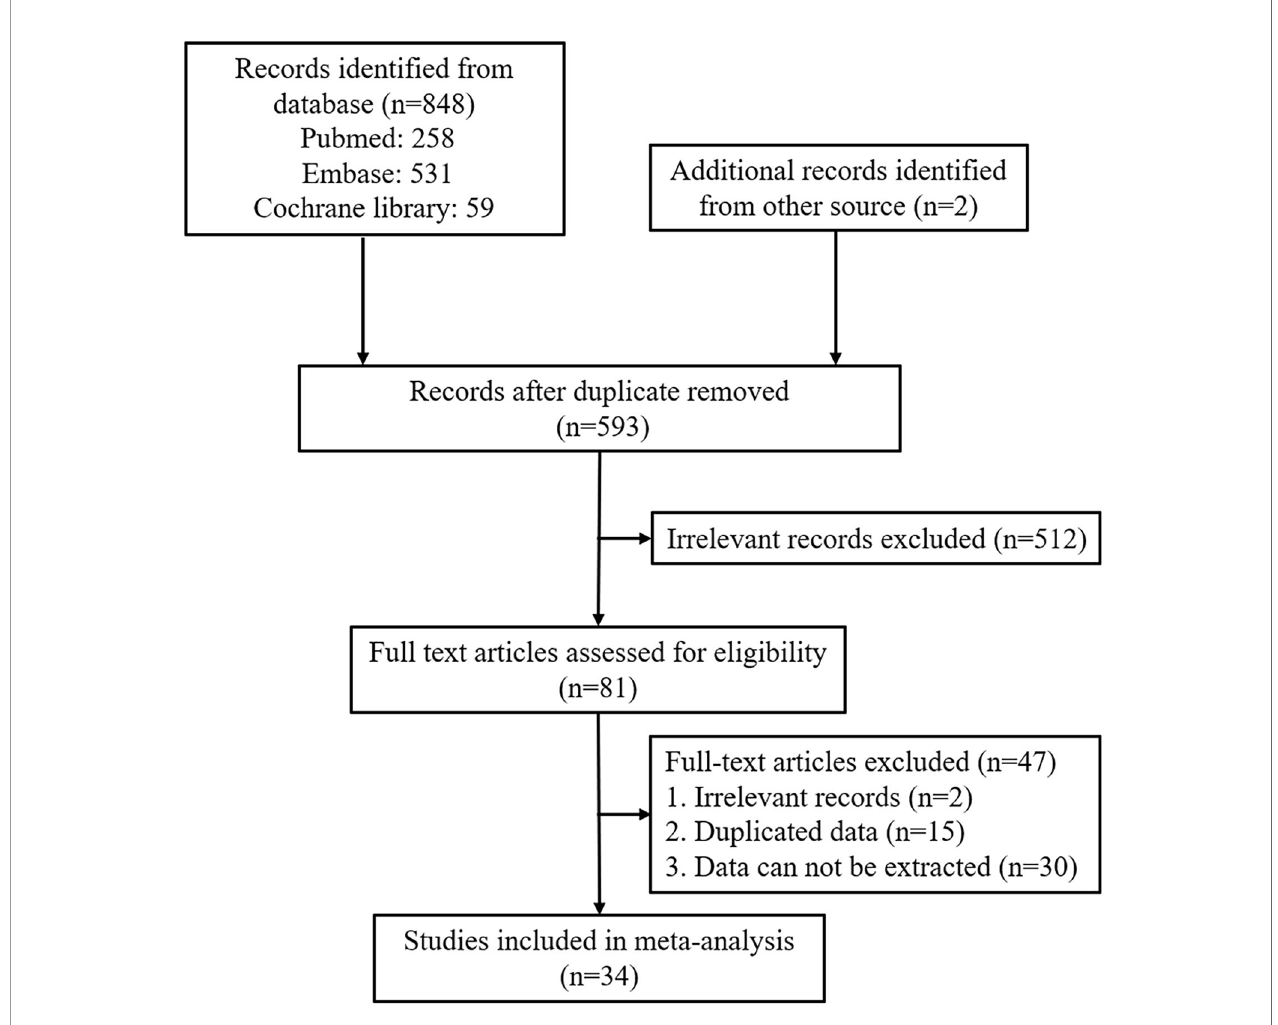
FIGURE 1 | Flowchart of the study selection